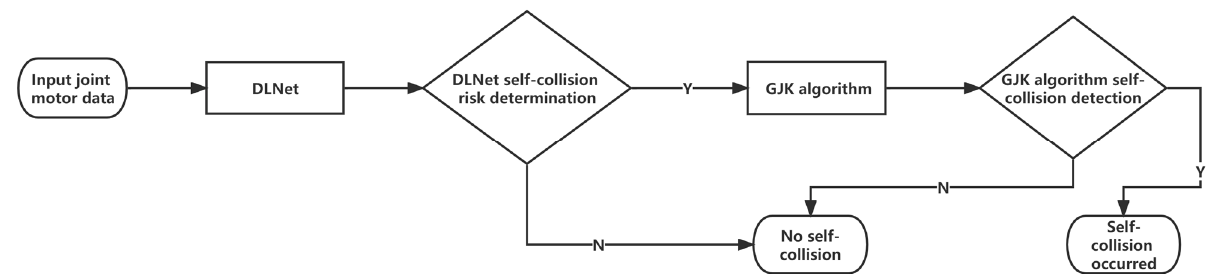
Figure 7. Flowchart of DLGJK algorithm self-collision detection.